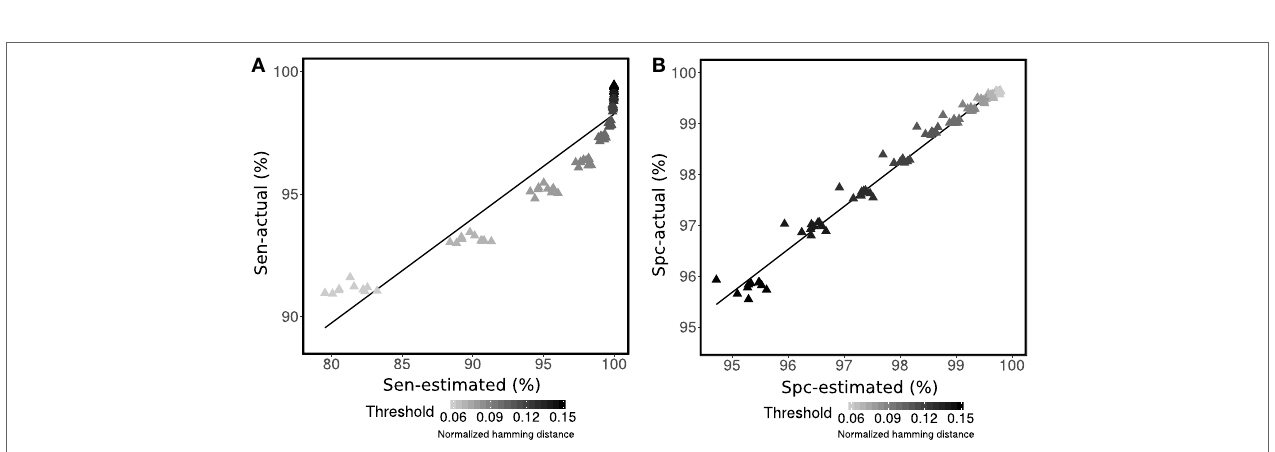
FIGURe 2 | Performance assessment of (A) sensitivity (Sen) and (B) specificity (Spc) for determining membership in a multi-sequence clone. Mixture modeling of the distance-to-nearest distribution was used to estimate sensitivity and specificity for each specified value of the threshold (points) according to equation set 2. The estimated performance (Sen-estimated and Spc-estimated) was compared with actual performance (Sen-actual and Spc-actual) for simulated R1.1–R1.10 data from Gupta et al. (4) across a wide range of thresholds (shades of gray for each point).